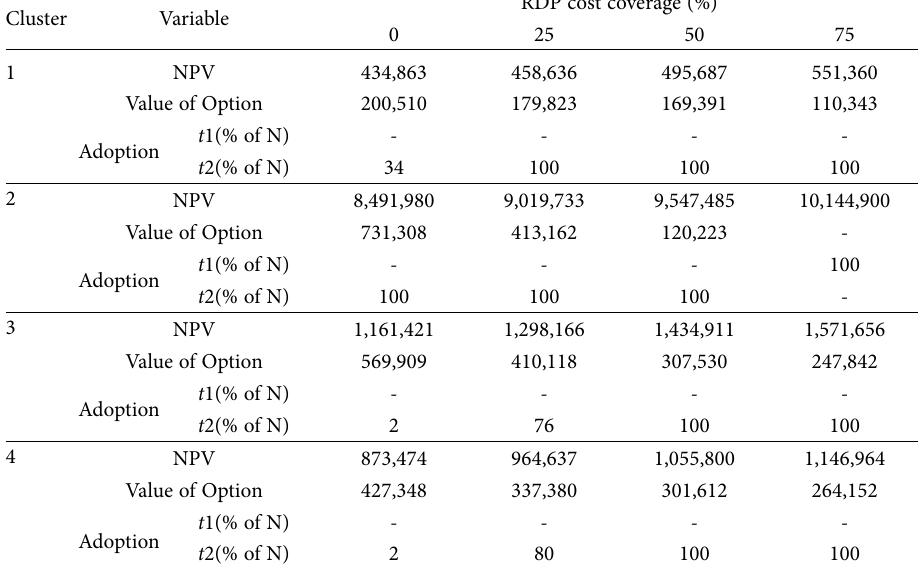
Table 5. Results with uncertainty in milk prices (€ per farm) Cluster